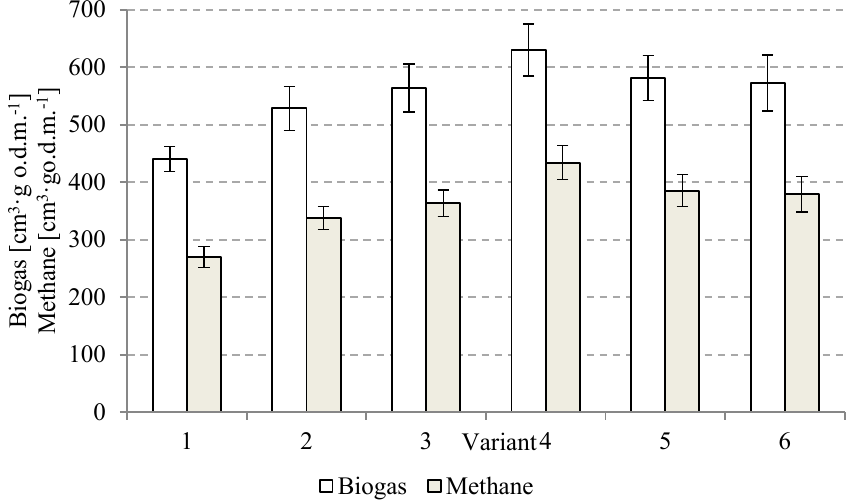
Figure 2. Effect of technological variant on biogas and methane production.